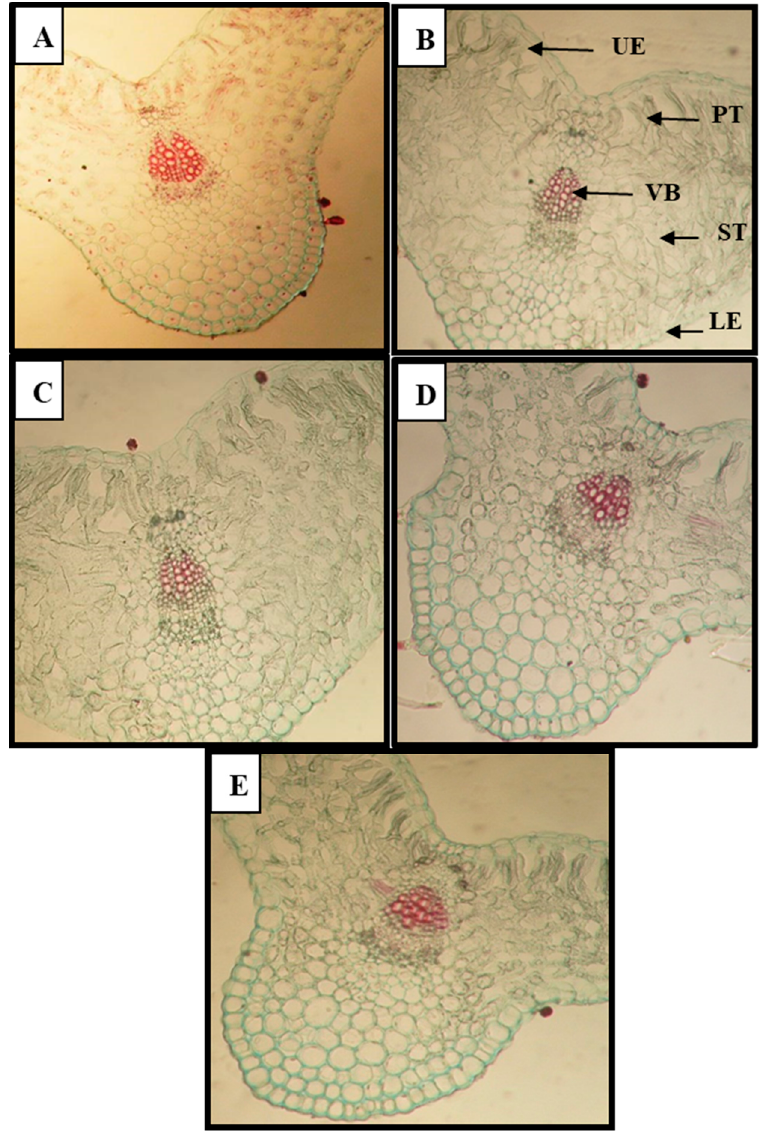
Figure 3. Effect of spent mushroom substrate extract (SMSE) , and mushroom culture filtrate (MCF) and Roundup on anatomical characters of infested faba bean leaves (leaflet) with broomrape in the sensitive cultivar (Sakha3) during the second season (2018/2019). A . Control of sensitive cultivar Sakha3 (without any treatment) (SC). B . Spraying + soil amendment with 10% solution of SMSE (S2). C . Spraying + soil amendment with 10% MCF (S5). D . soil amendment with 10% MCF (S6). E . Spraying with